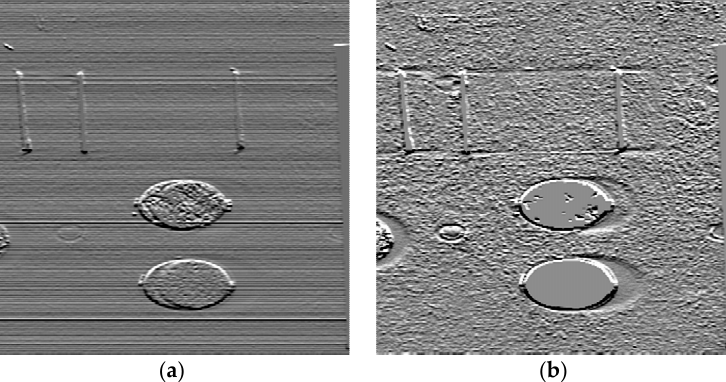
Figure 5. ( a ) Grey scaled image of the along track smoothed across track gradient of the first band of raw SWIR, ( b ) Grey scaled image of the along track smoothed across track gradient of the first band of radiometrically correct (perfect destriping)